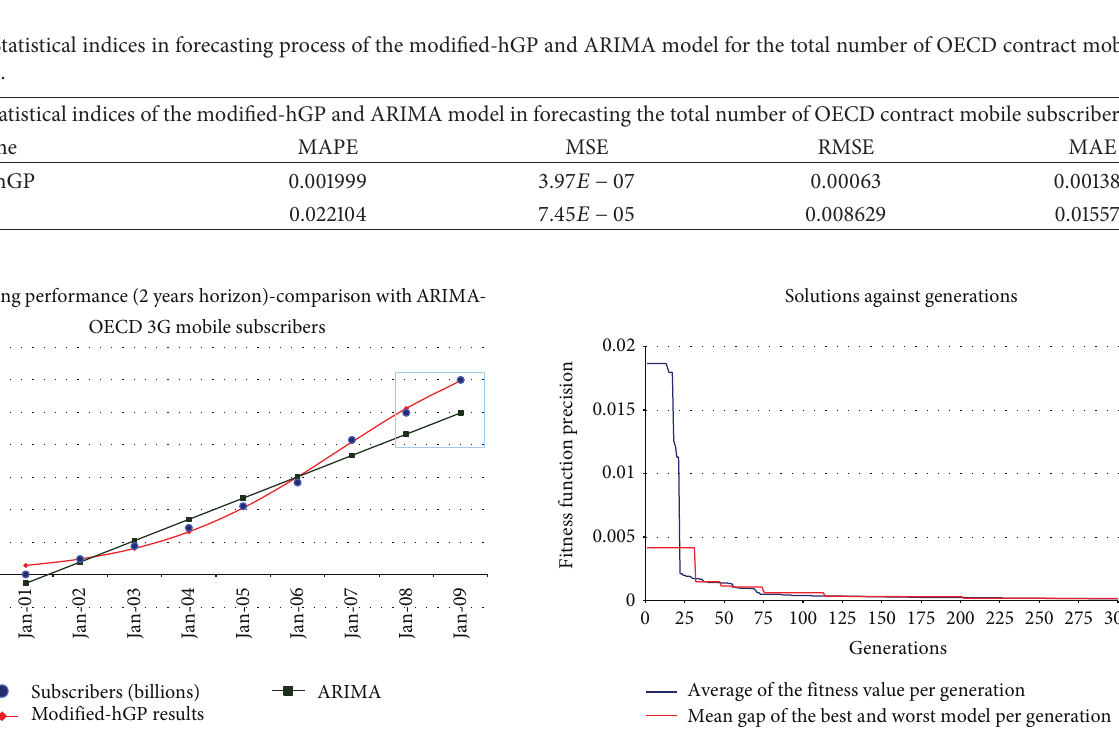
Figure 35: Testing the robustness of the forecasting